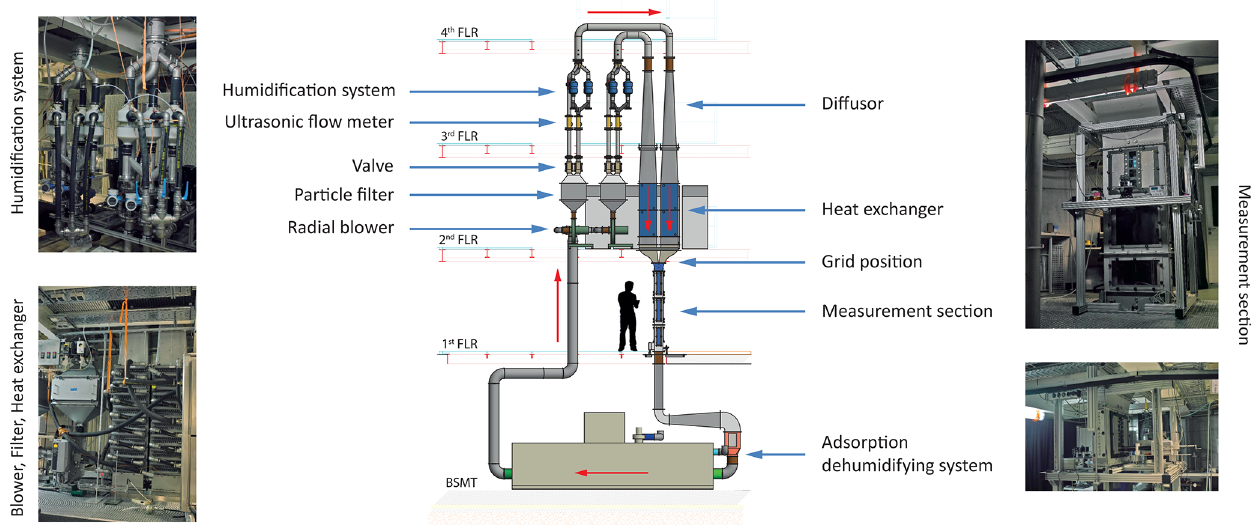
Figure 1. A schematic of LACIS-T including photos of individual components (© by Ingenieurbüro Mathias Lippold, VDI; TROPOS). The red arrows indicate the flow direction.